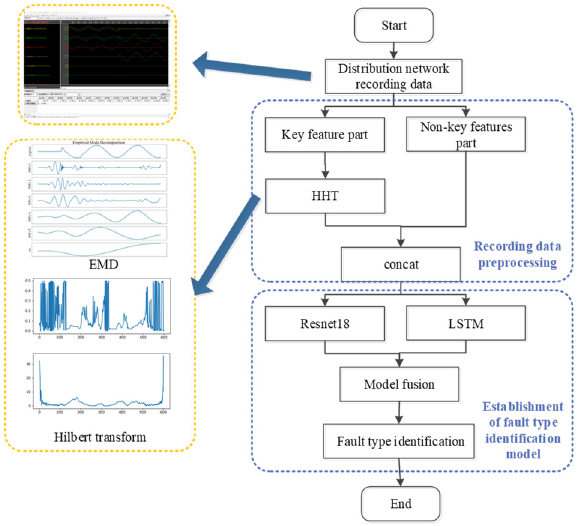
Figure 7. Overall process of the single-phase grounding fault type identification method.